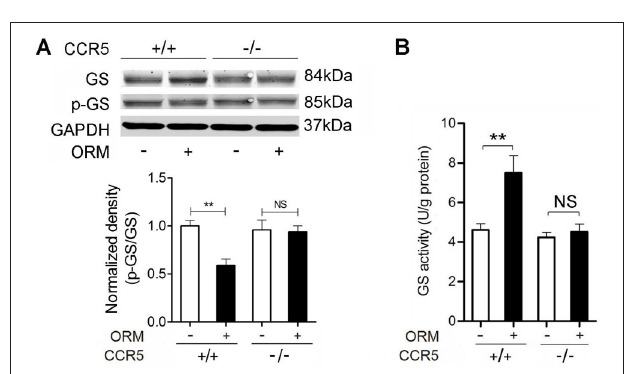
FIGURE 4 | CCR5 Mediates the Role of ORM in Promoting the Expression and Activity of Glycogen Synthase in Skeletal Muscles. (A) Representative western blotting of soleus muscle glycogen synthase and phosphorylated glycogen synthase and quantification of the results 30min after the treatment with vehicle or 200mg/kg ORM (tail vein injection) in CCR5 + / + and CCR5 − / − mice. n = 6 per group. (B) The activity of glycogen synthase in soleus muscle of mice treated as mentioned in (A) . n = 6 per group. GS: glycogen synthase; p-GS: phosphorylated glycogen synthase. All data are expressed as the mean ± s.d. NS, non-significant, ** P < 0.01 by two-way ANOVA with Turkey’s post-hoc test.